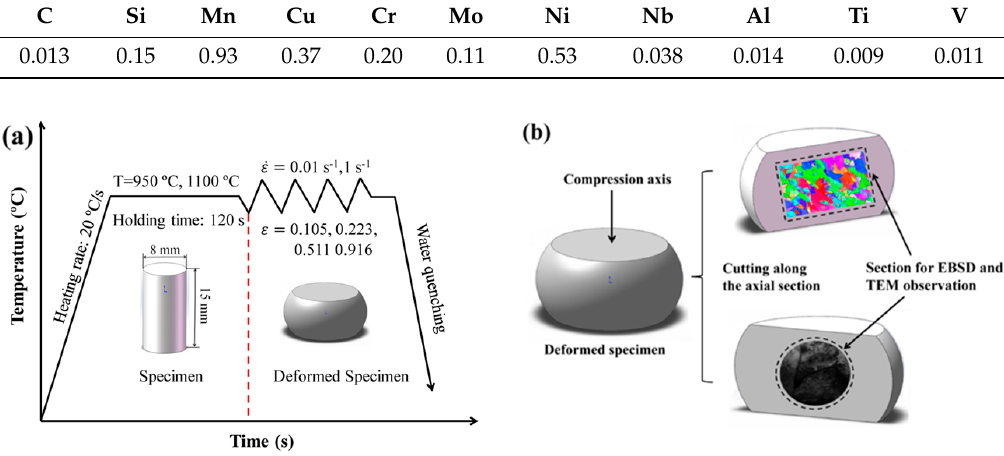
Table 1. Chemical composition of high-strength low-alloy (HSLA) steels (wt.%, Fe balance). C Si